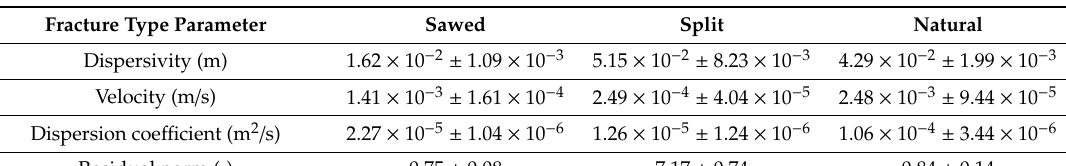
Table 2. Transport parameters obtained through the advection–dispersion equation (ADE) fit with the standard deviation values.